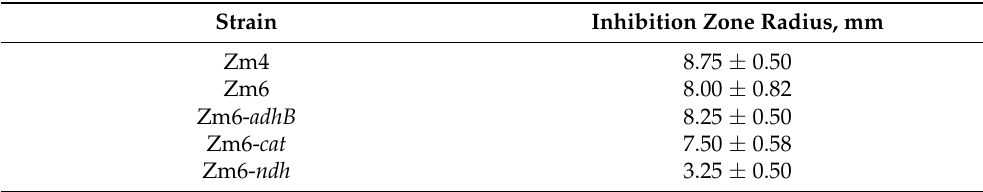
Table 1. Inhibition zones in E. coli agar overlays with several Z. mobilis